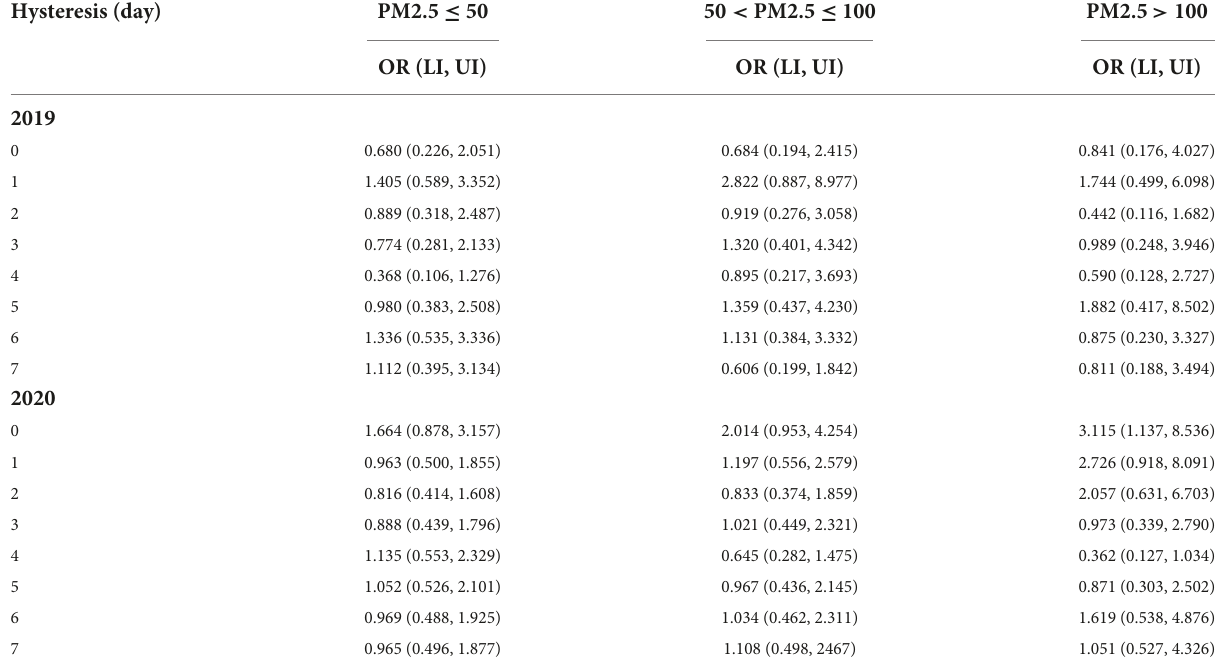
TABLE 3 Hysteresis effect of different concentration grade of